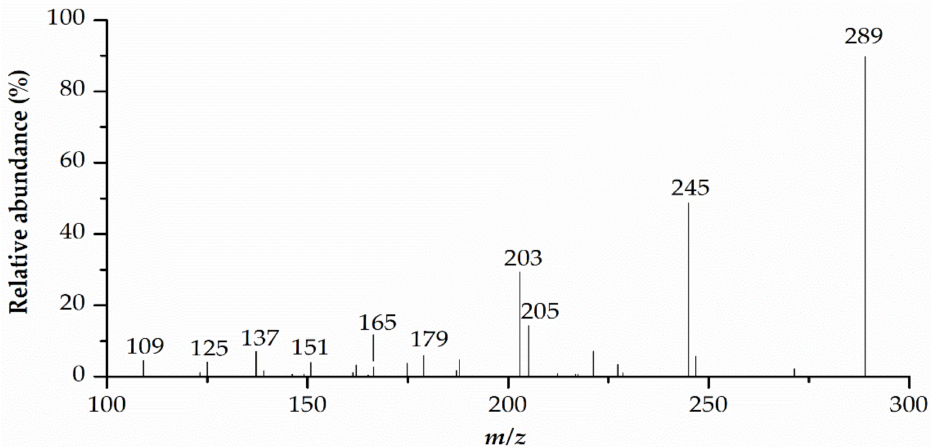
Figure 7. MS/MS spectra for catechin (peak 6 ). The peak number corresponds to that in Table 2.